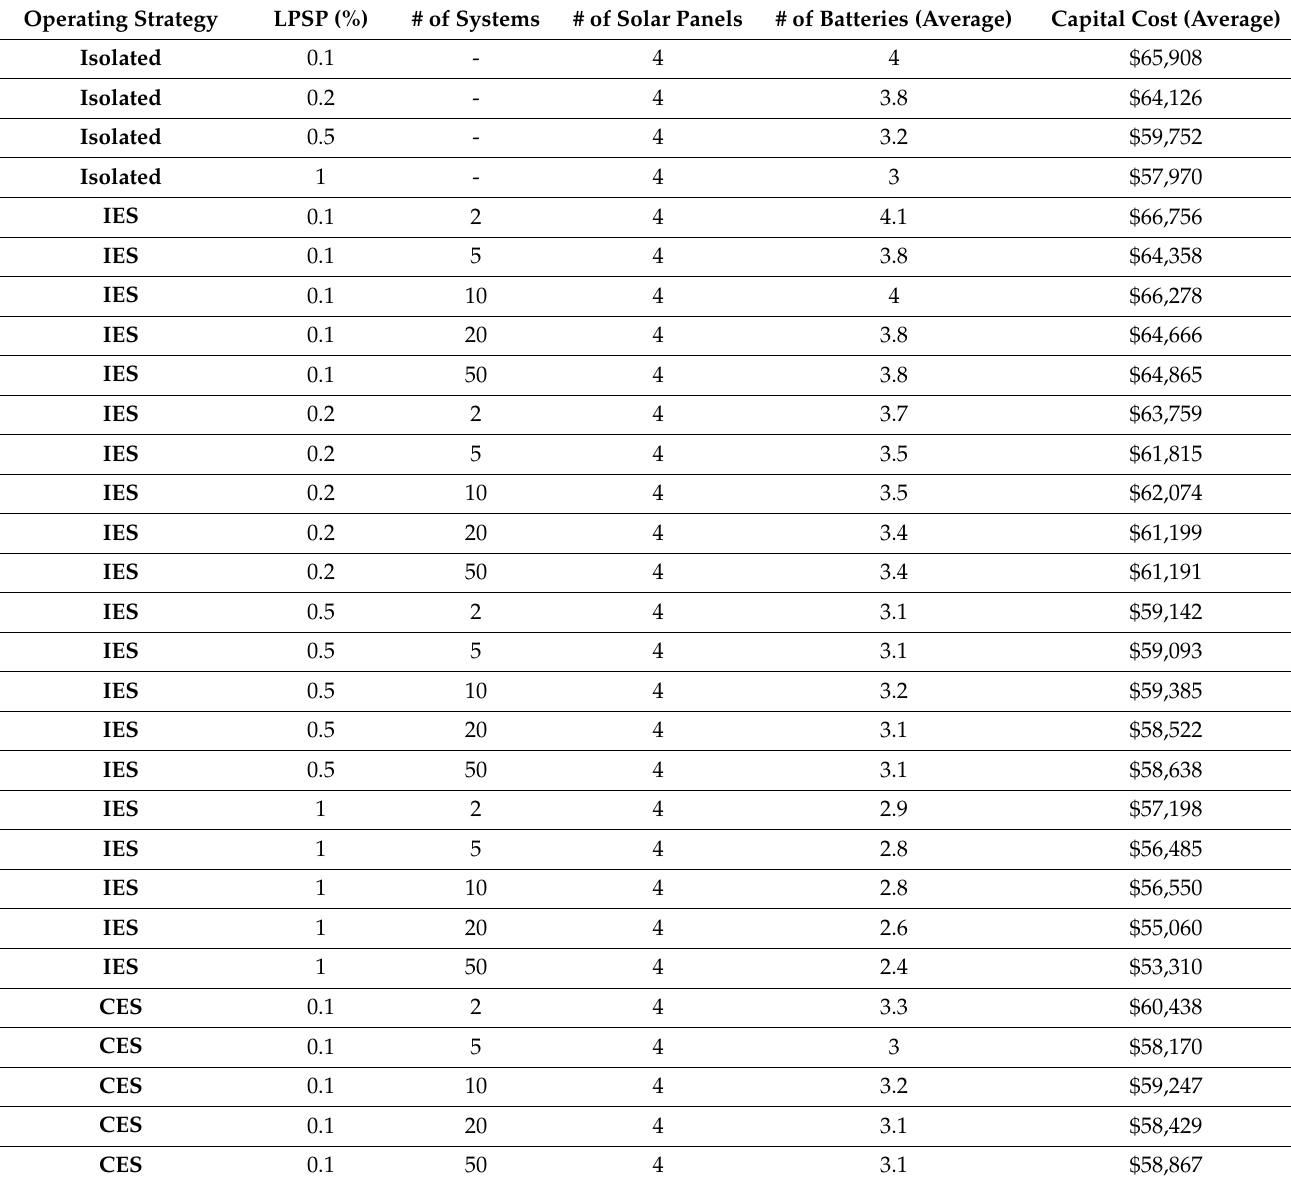
Table A3. Summary table for Phoenix showing average lowest cost configuration for each